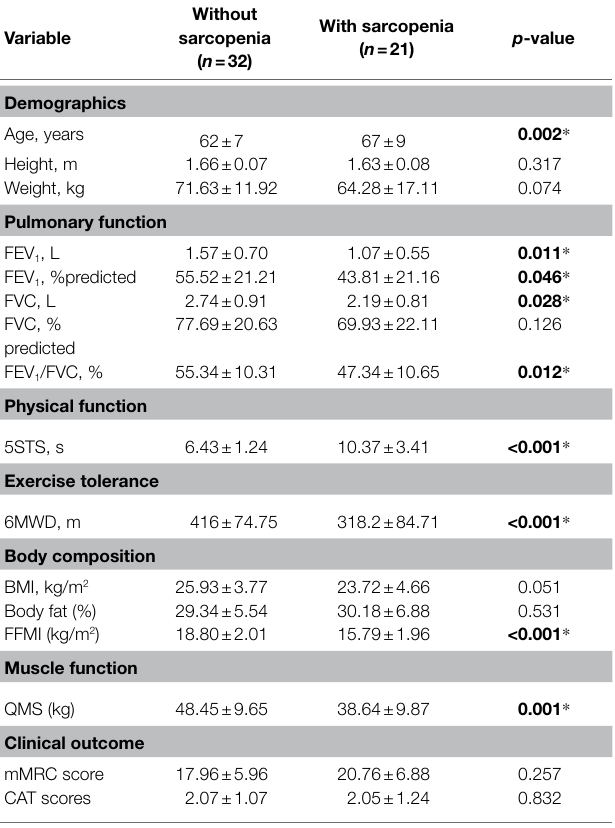
TABLE 4 | Characteristics of the patients with/without sarcopenia. Without Variable